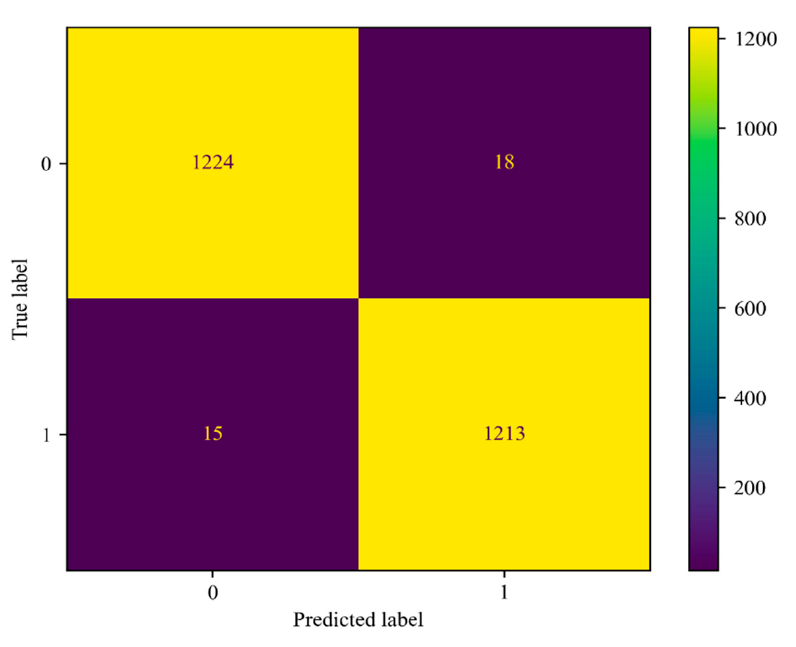
Figure 12. SVM (RBF kernel) receiver operating characteristic (ROC) curve. As observed from Table 3, some features are essential to increase the classification accuracy, such as the RGB statistical moments and the HSV statistical moments. However, not all the GLCM features are effective. Table 3. Recall accuracy of the proposed model compared with different feature configurations . Cross-Validation Recall Accuracy Feature